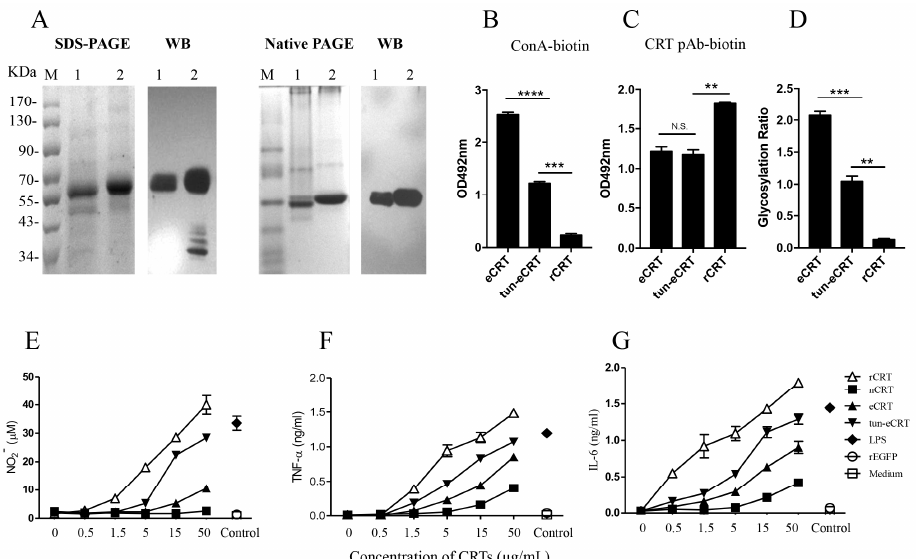
Figure 4. The effect of de-glycosylation on the immune-stimulatory effect of eCRT. Confluent CHO-CRT cells were cultured in serum-free medium in the presence of 5 µg/mL tunicamycin for 48 h. The supernatant was then harvested for purification of tun-eCRT using Ni-columns. Samples of tun-eCRT (lane 1) and eCRT (lane 2) were separated by SDS-PAGE or native PAGE and detected by WB using rabbit anti-CRT polyclonal antibody ( A ). The glycosylation levels of eCRT, tun-eCRT and rCRT were compared in biotin-ConA binding assays ( B ) with CRT-Based ELISAs as even protein coating control ( C ). The glycosylation ratios of the CRT preparations were determined by OD ConA /OD pAb ( D ). Mouse peritoneal macrophages were stimulated with increasing concentrations of eCRT, tun-eCRT, nCRT or rCRT for 24 h, NO ( E ), TNF- α ( F ) and IL-6 ( G ) in the culture supernatant were quantitated by Griess Reagent and ELISAs, respectively. Results are expressed as mean ± SD of three replicates. **** p < 0.0001;*** p < 0.001; ** p < 0.01. These are representatives of three independent experiments.